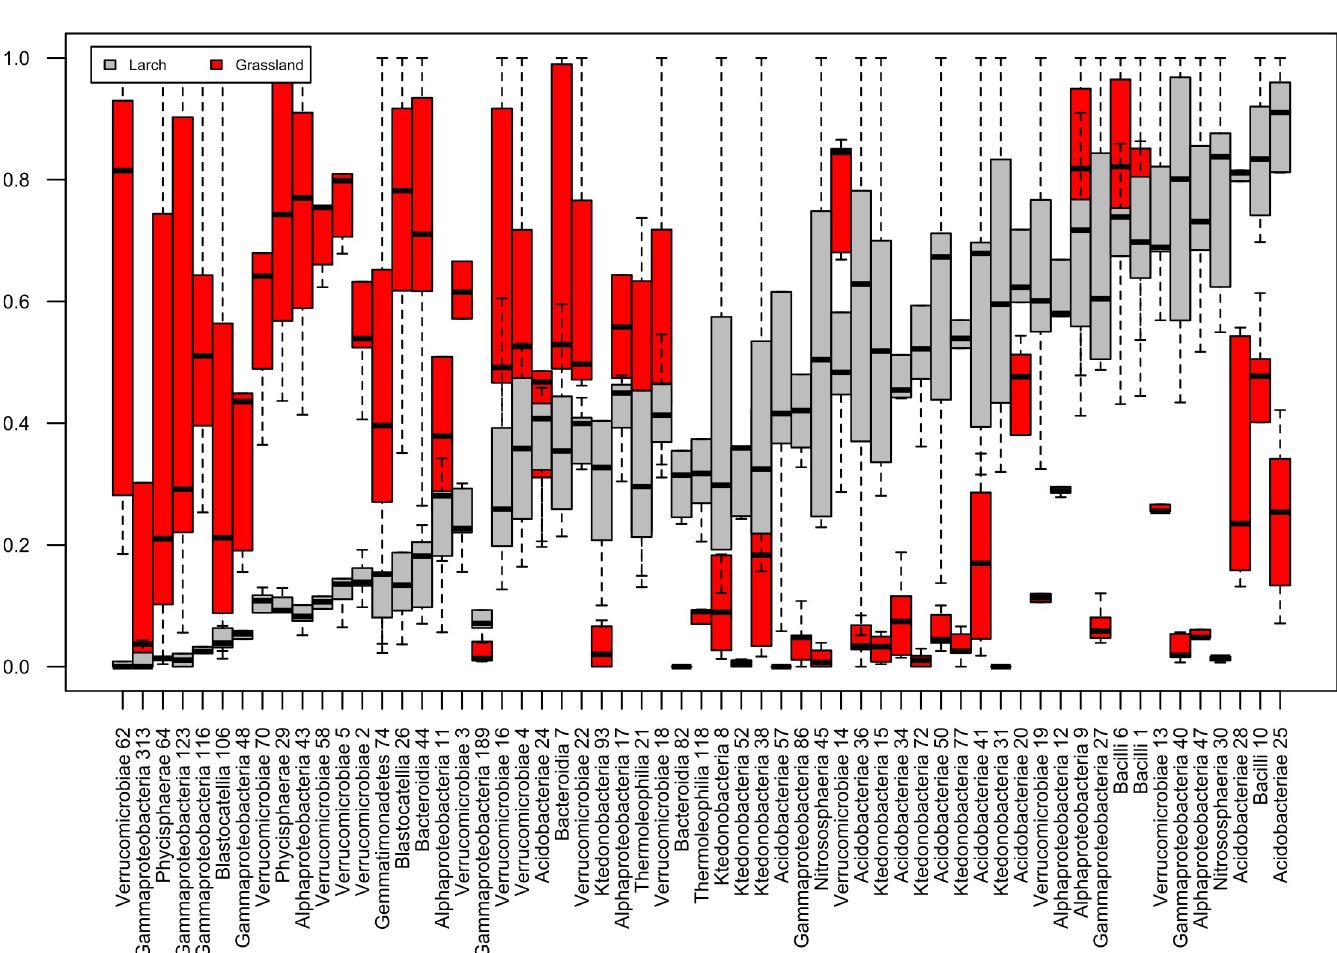
Fig 4. Abundance of dominant phylotypes in the soil microbiome under grassland vegetation (Grassland) and artificial plantations of larch (Larch). Taxonomic identification of phylotypes � is given at a high taxonomic level (at the level of prokaryote classes). Numbers denote ASV numbers in the original dataset. The boxplot is an average of 15 samples for each taxon, (i.e., without considering the depth factor). The values of the proportion of each phylotype are normalized to the maximum from both biotopes to allow comparison of the content of individual taxa between biotopes. S4 Table shows the numerical values of the averages (dash in the boxplot) to Fig 4, sorted in descending order of difference for the taxa between biotopes. � The complete taxonomic assignment of 59 ASVs is presented in S4 Table.